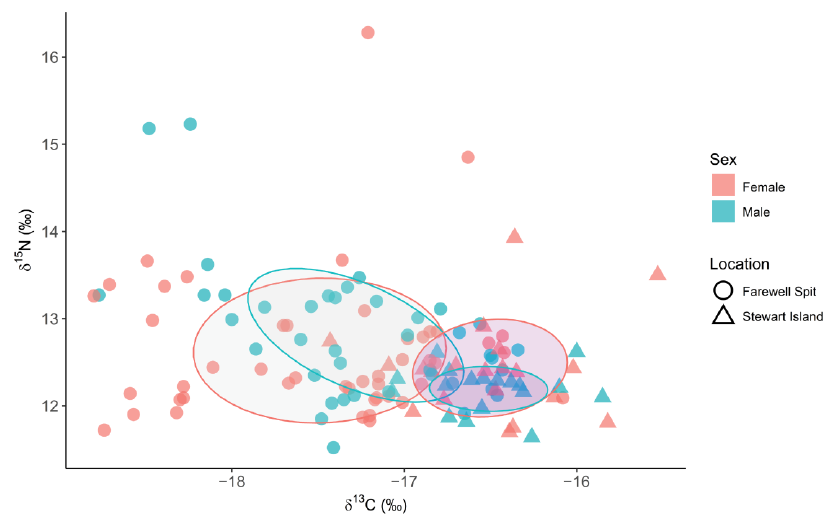
Figure 4. Long-finned pilot whales ( Globicephala melas edwardii ) isotopic niche overlap of carbon and nitrogen ( δ 13 C and δ 15 N) values between males ( n = 40) and females ( n = 47) stranded at Farewell Spit, and males ( n = 18) and females ( n = 20) stranded at Stewart Island between 2009 and 2017. Stewart Island is represented as triangles and purple filled ellipses, and Farewell Spit as circles and grey filled ellipses, males are indicated in green and females in peach. Ellipses represent 40% of the data.